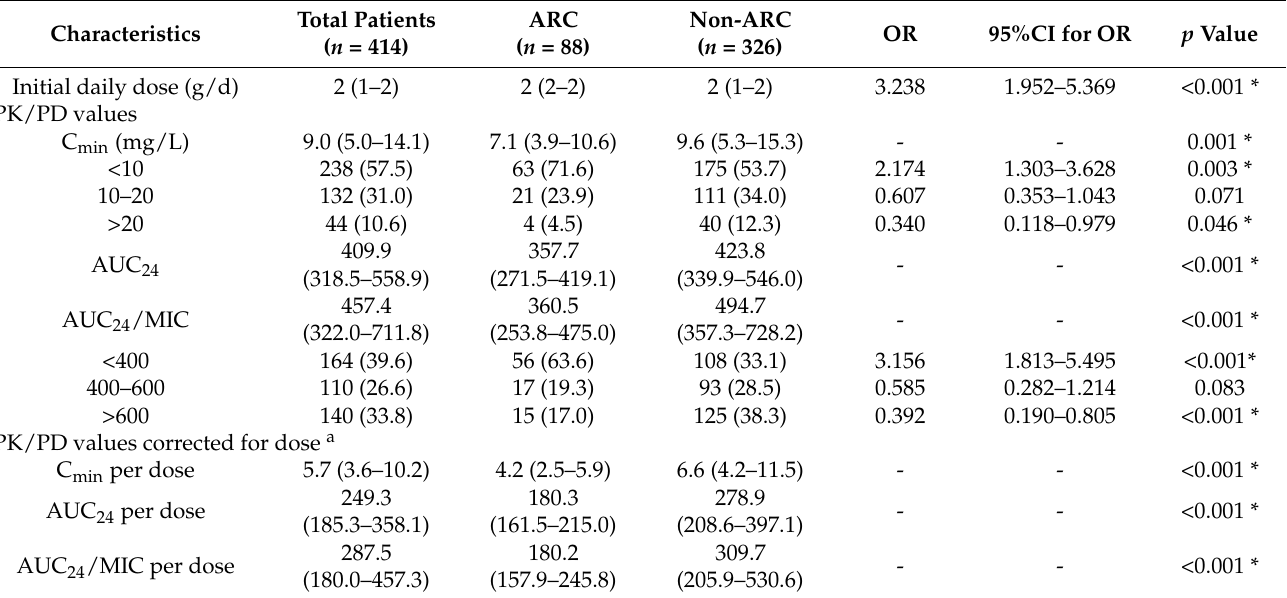
Table 3. Vancomycin dosing and PK/PD analysis.